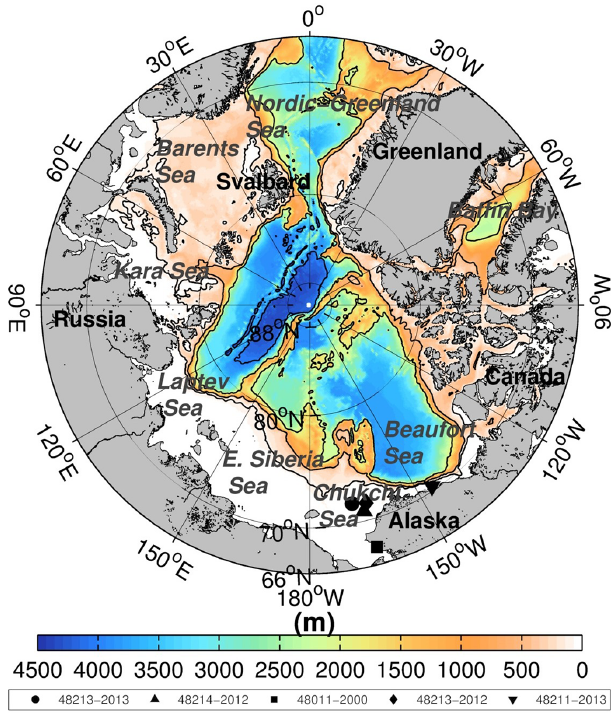
Figure 1. Regional seas of the Arctic Ocean with bathymetry (color), buoy locations (black symbols), and 4000, 2000, 500, and 100m depth contours (black